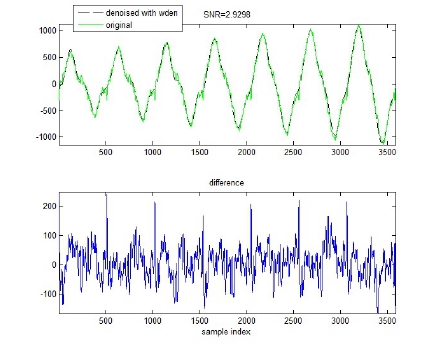
Figure 13. Ascending slope, M = 0.06, most sig- nificant noise. Top - original signal and signal denoised with wden. Bottom – di ff erence be- tween original signal and signal denoised with wden.